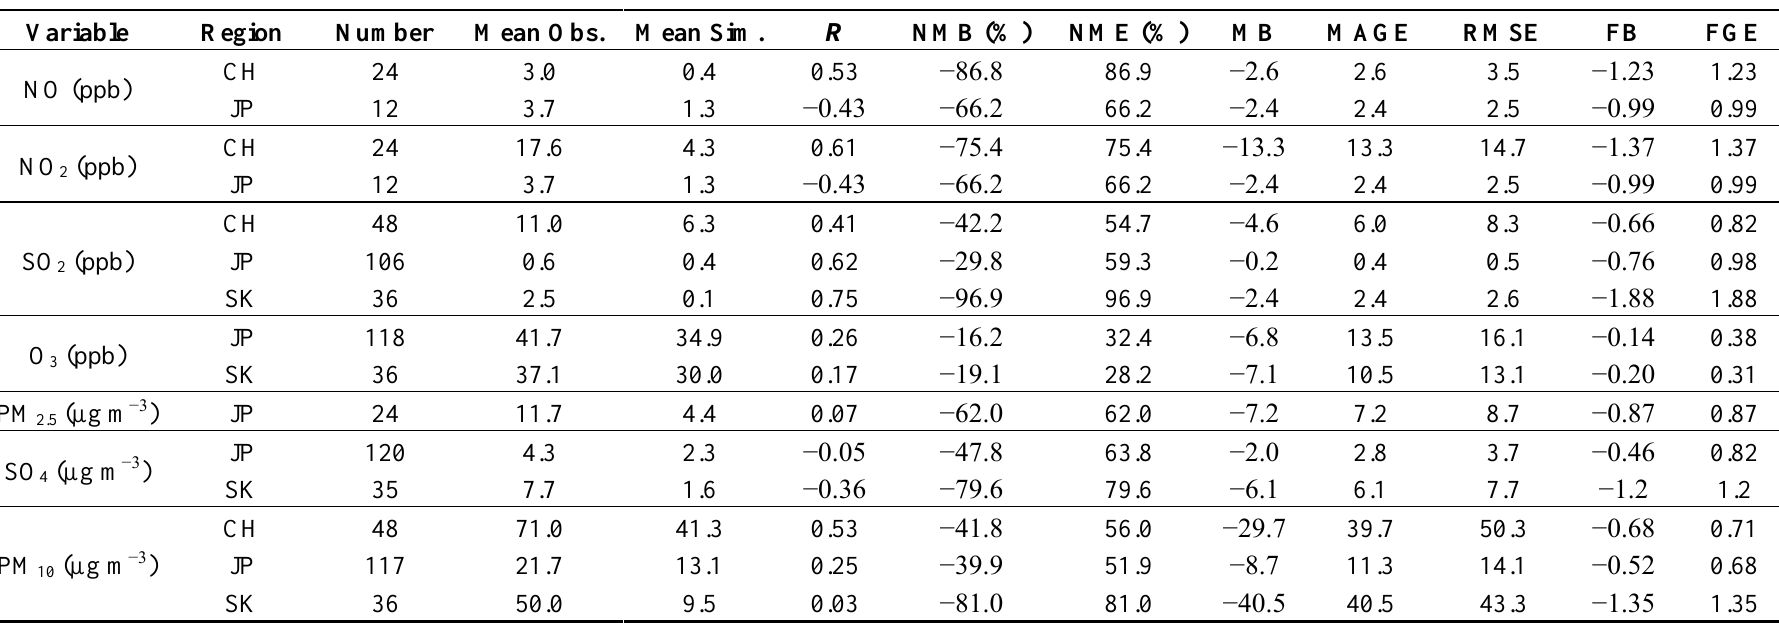
Table 5. Performance statistics for surface chemical concentrations of gaseous species for 2006 against